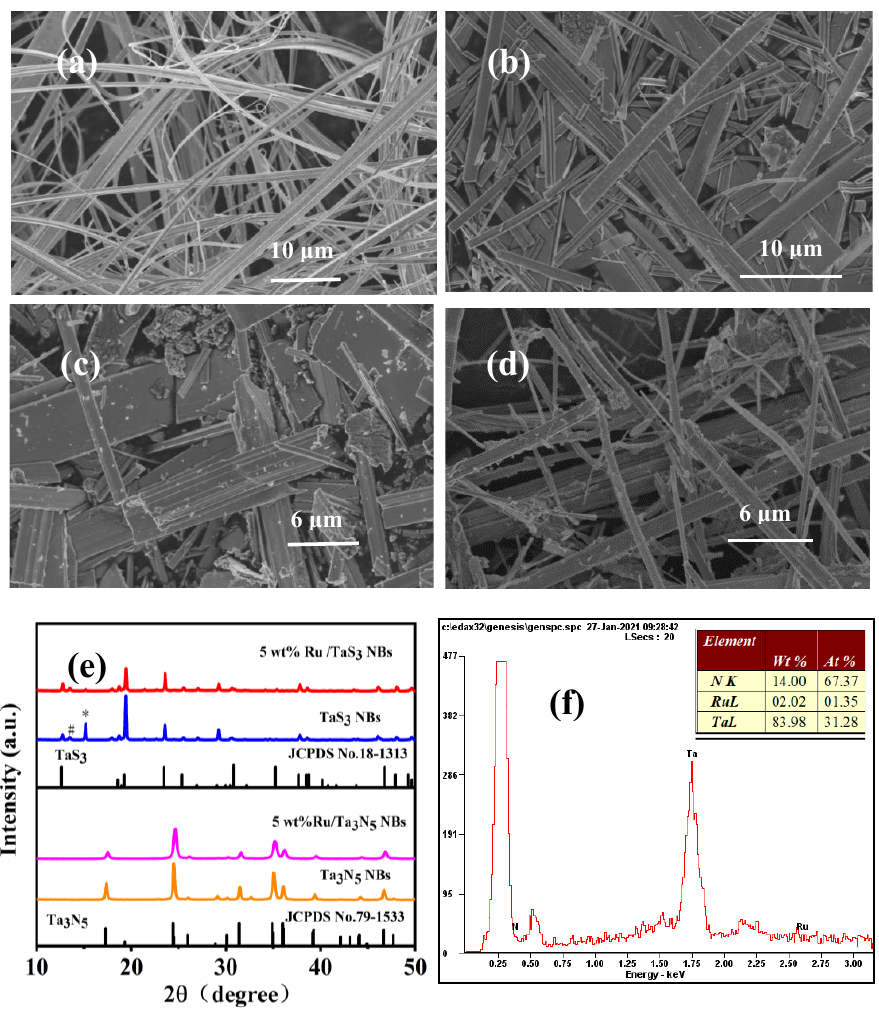
Figure 1. SEM images of ( a ) TaS 3 NBs, ( b )Ta 3 N 5 NBs, ( c ) 5 wt% Ru/Ta 3 N 5 NBs, and ( d ) 5 wt% Ru/TaS 3 NBs; ( e ) XRD patterns of TaS 3 NBs, Ta 3 N 5 NBs, and 5 wt% Ru/Ta 3 N 5 NBs (* and # are unknown peaks); ( f ) EDX spectrum of 5 wt% Ru/Ta 3 N 5 NBs (inset: chemical components). The Ta, N, and Ru elements in the 5 wt% Ru/Ta 3 N 5 NBs are confirmed by the energy dispersive X-ray spectroscopy (EDX) shown in Figure 1f, and the mass ratio (%) of Ta, N and Ru is 83.98:14.00:2.02, demonstrating that the percentage of Ru is lower than 5 wt% (real value), although it is possible that the EDX analysis is only approximate. Figure 2a,b present the high-resolution transmission electron microscopy (HRTEM) images of 5 wt% Ru/Ta 3 N 5 NBs, and it is evident that the addition of Ru does not alter the morphology of Ta 3 N 5 . The Ru NPs with a size of about 3 – 15 nm can be observed on Ta 3 N 5 . As shown in Figure 2a,b, lattice stripe spacing of 0.22 nm and 0.50 nm belong to the (100) plane of Ru and the (002) plane of Ta 3 N 5 , respectively.